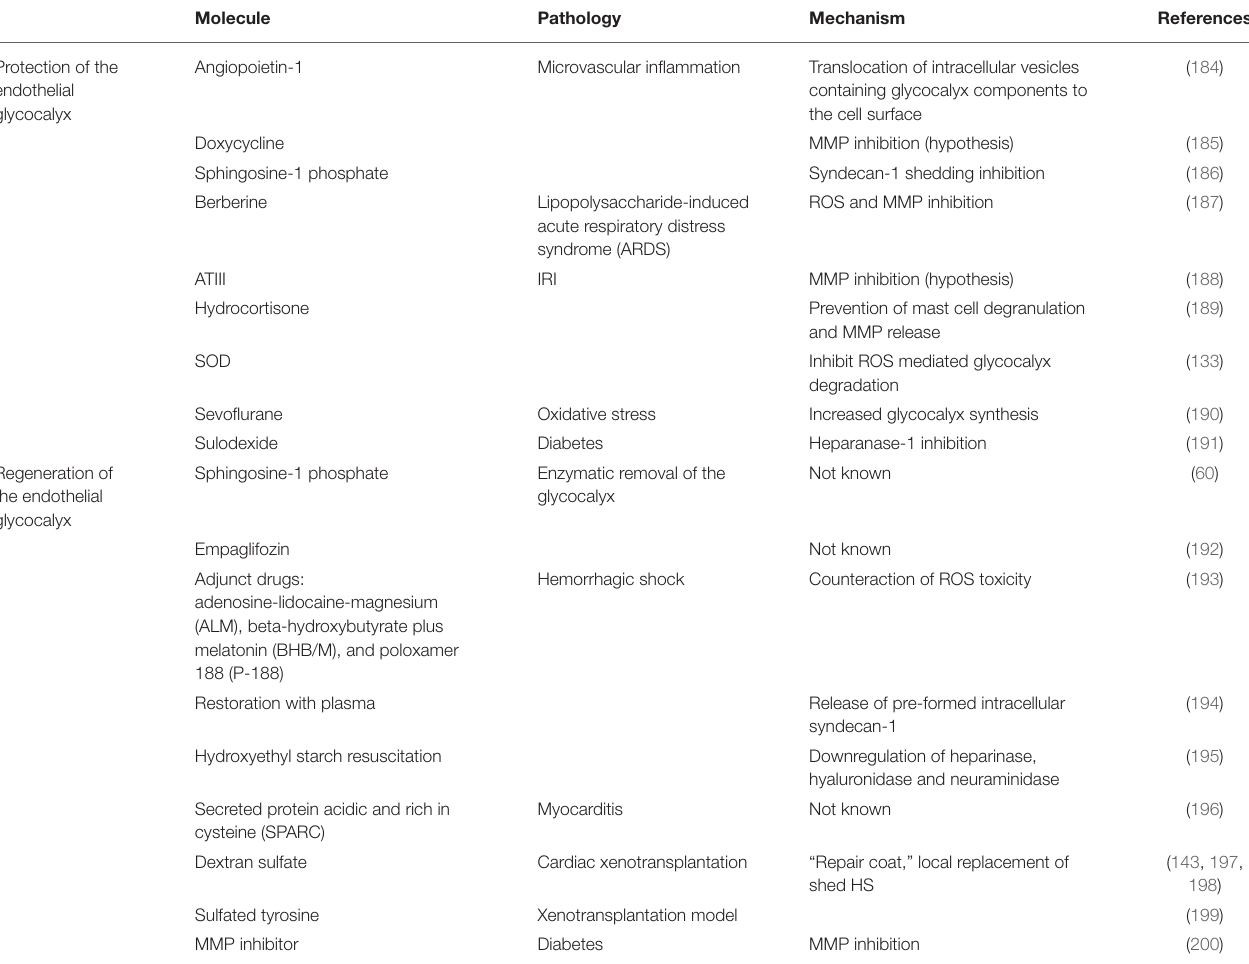
TABLE 1 | Protection and regeneration of the endothelial